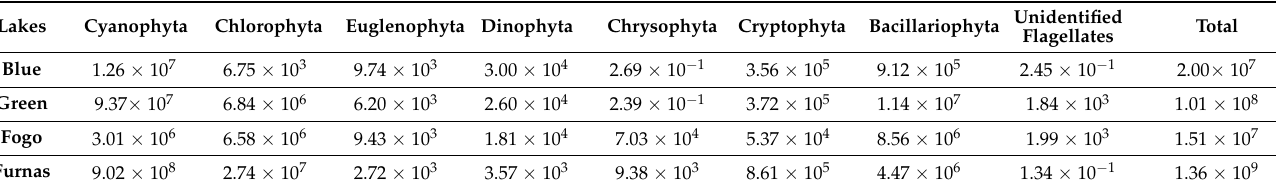
Table 5. Threshold levels considered for each phytoplankton phylum in every lake.